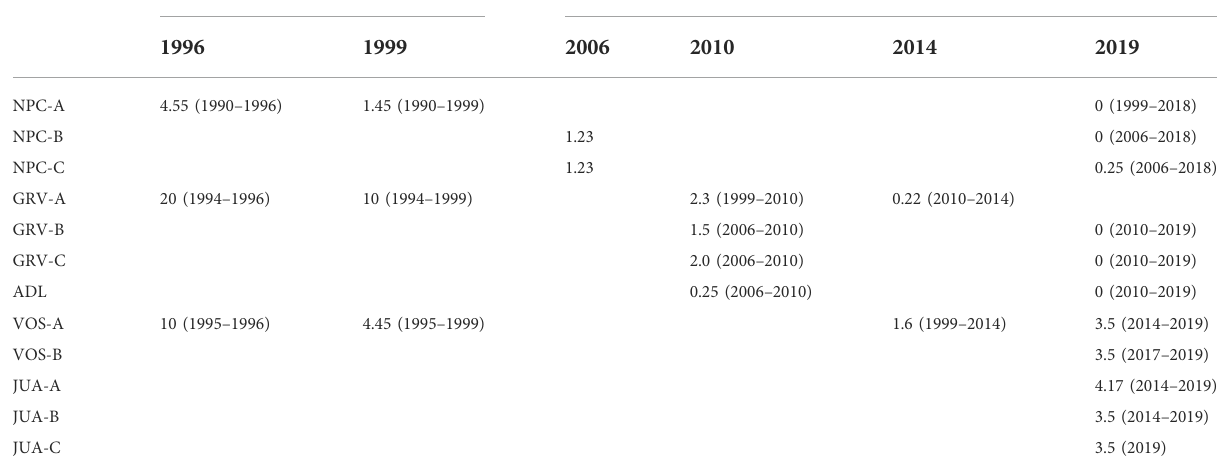
TABLE 1 Creep rate calculations based on various survey